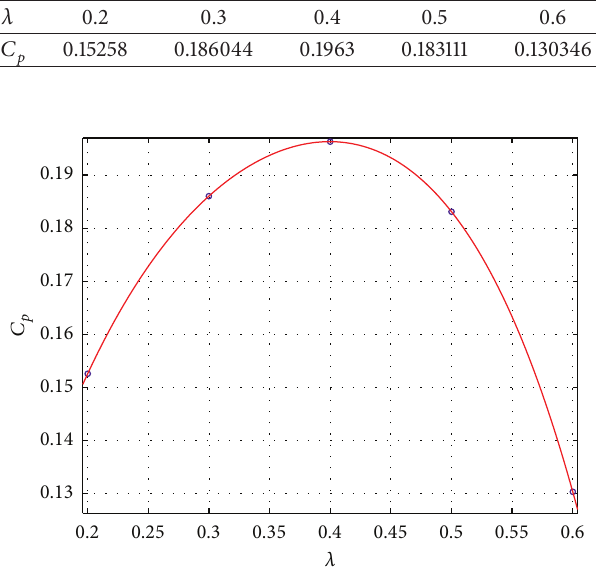
Figure 6: The power coefficient 𝐶 𝑝 (𝜆)